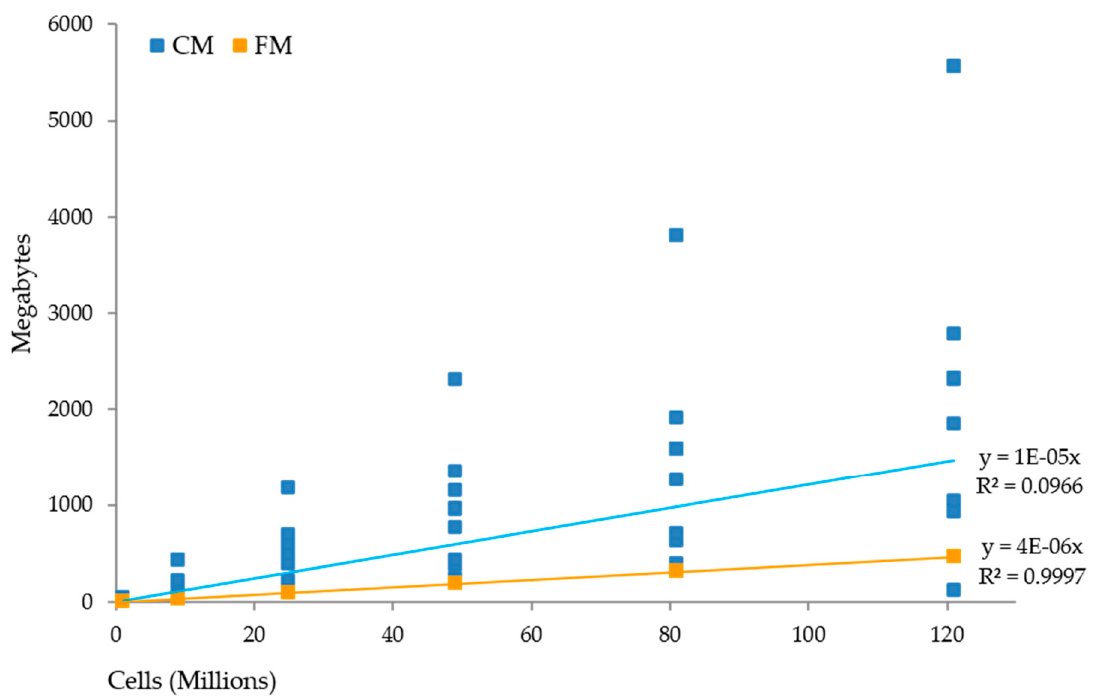
Figure 6. Conventional modeling (CM, blue) and function modeling (FM, yellow) regression results for storage space.